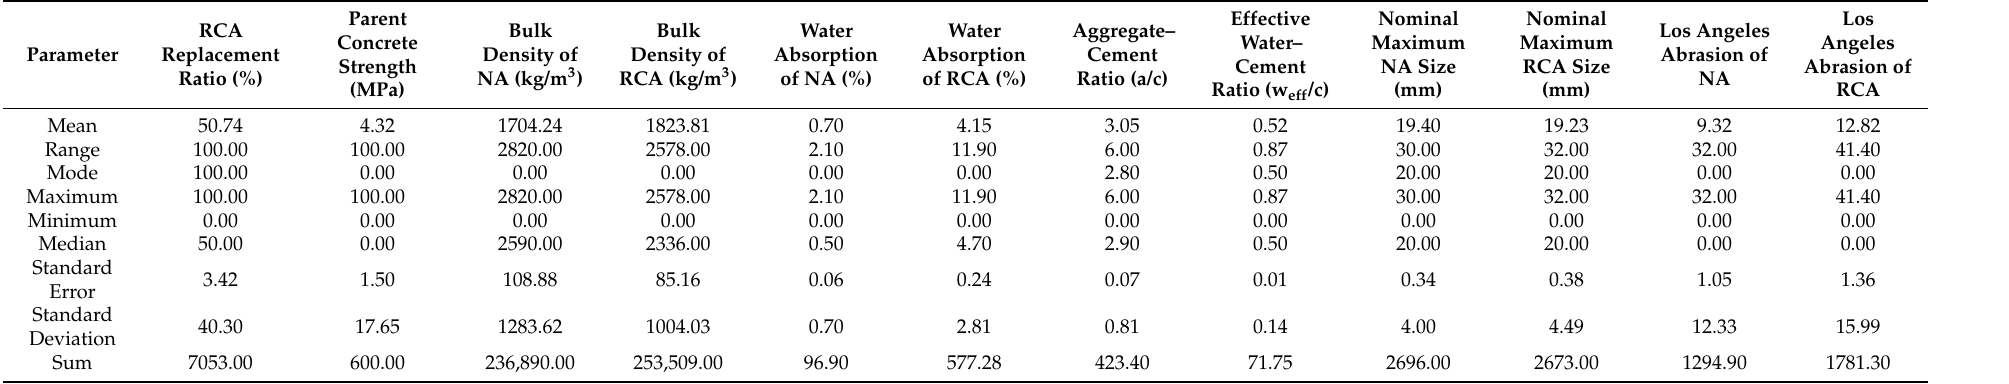
Table 2. Descriptive statistical values of input factors for the flexural strength